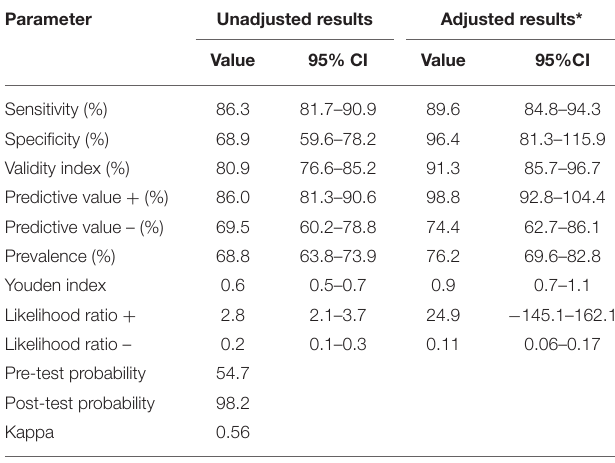
TABLE 1 | Evaluation of PLB test performance with an imperfect reference standard: Mammogram*.